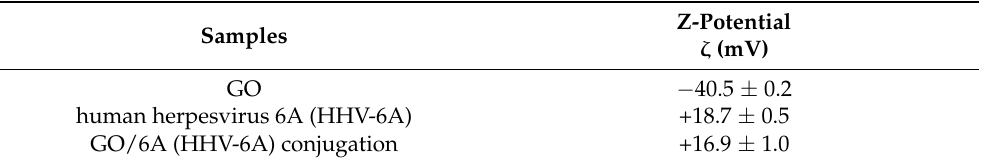
Table 2. Z-potential of the functionalized GO, the human herpesvirus 6A (HHV-6A), and the subsequent conjugation with the